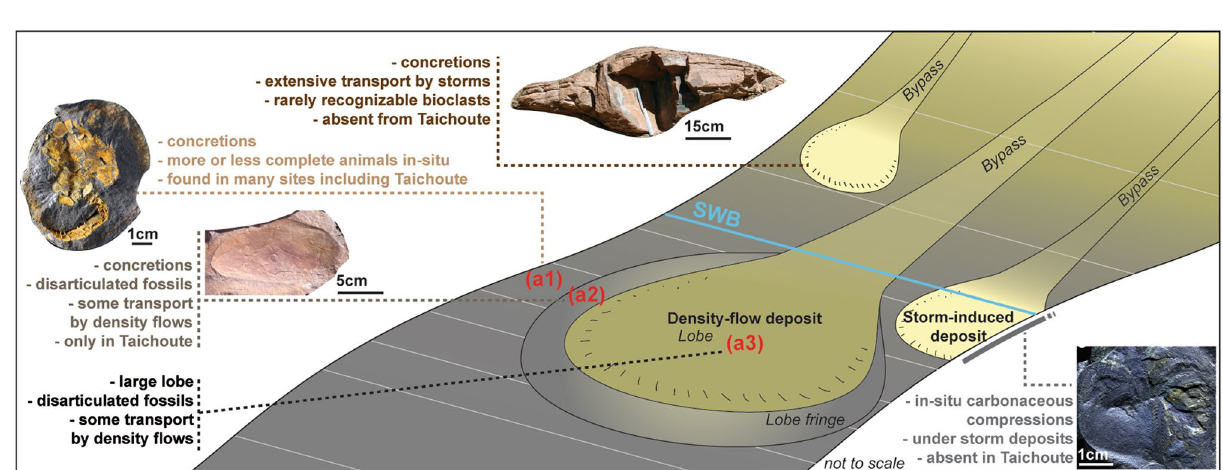
Figure 6. The different modes of preservation within the Fezouata Shale, their distribution, and the sedimentary processes at play for their formation. SWB: Storm Wave